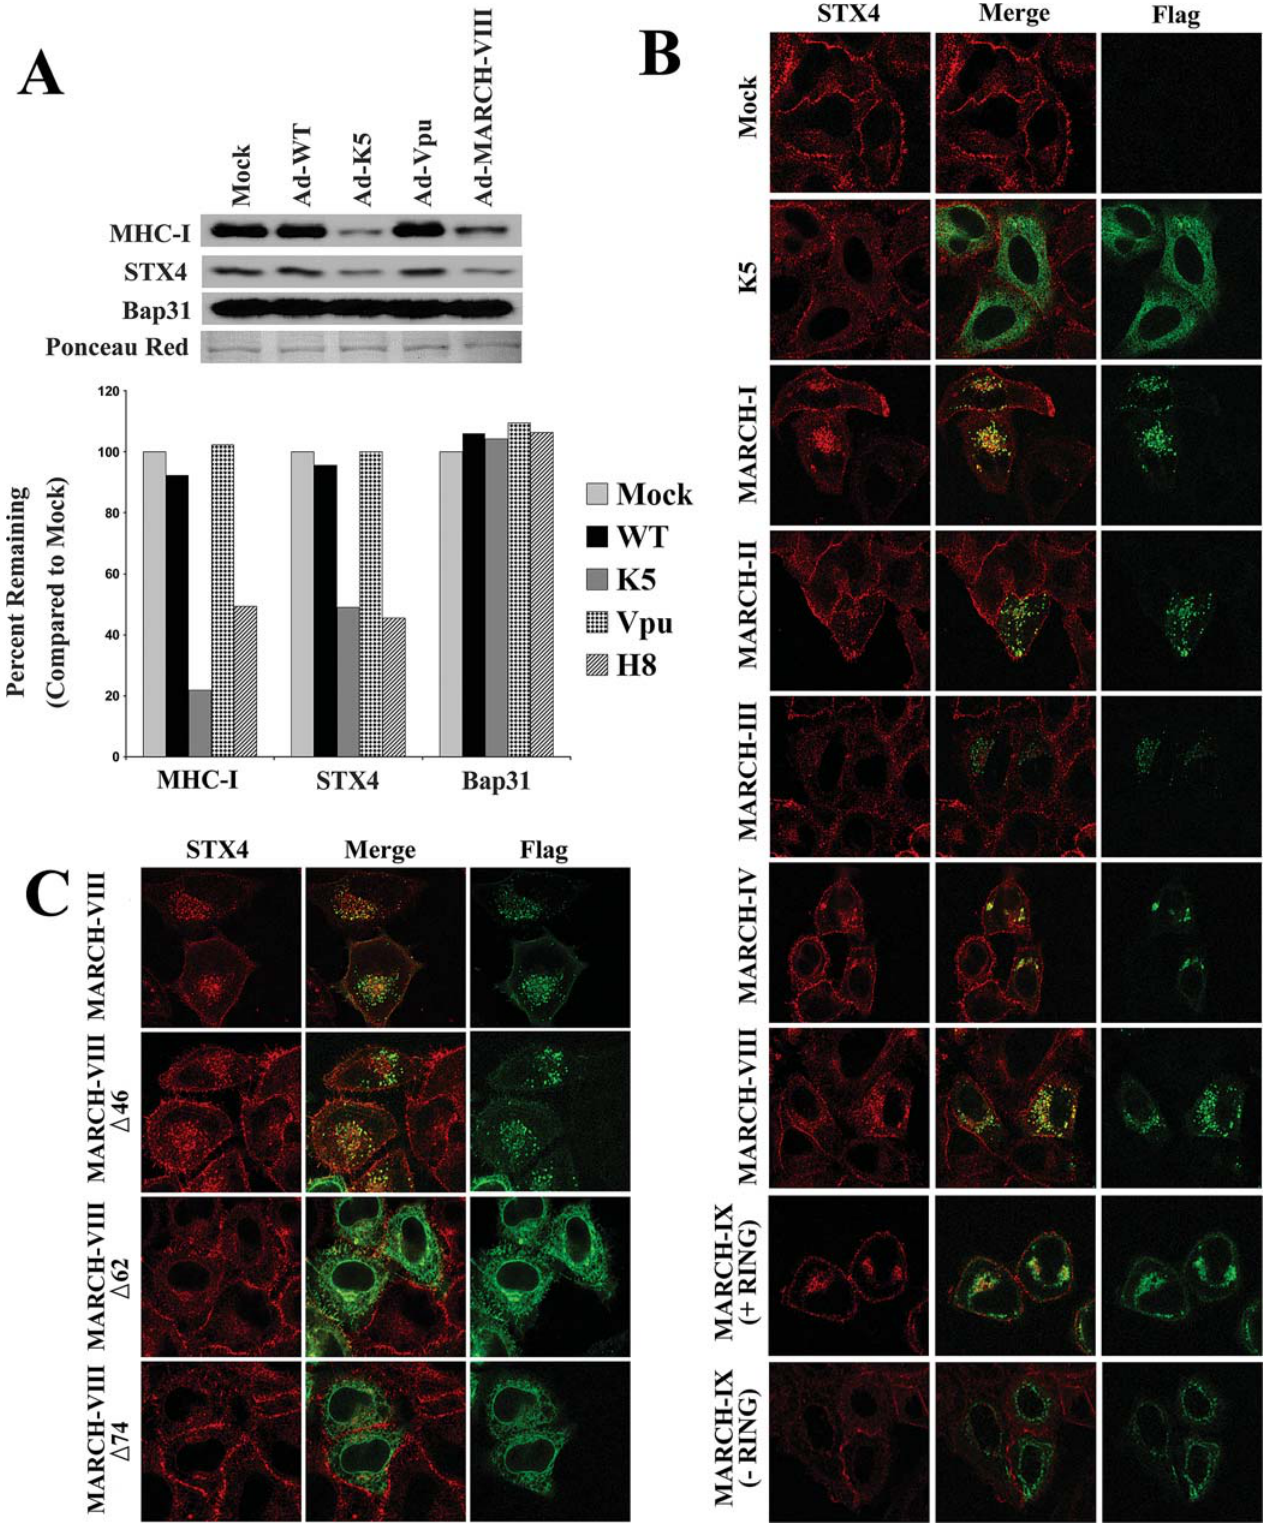
Figure 4. K5 Causes Downregulation but Not Relocalization of Syntaxin-4 (A) HeLa cells were transduced with Ad-WT, Ad-K5, Ad-vpu, or Ad-MARCH-VIII. Then 24 h post-infection, cells were harvested and whole cell lysates were analyzed as in Figure 3, except that antibodies specific for Syntaxin-4 were used. Expression of K5 resulted in a moderate but reproducible reduction of Syntaxin-4 levels. (B) To determine if K5 or MARCH proteins caused a relocalization of Syntaxin-4, HeLa cells were transfected with C-terminally FLAG-tagged versions of the E3 enzymes shown. Cells were then analyzed for the location of Syntaxin-4 (using an Alexa Fluor 594–conjugated secondary antibody, shown as red)